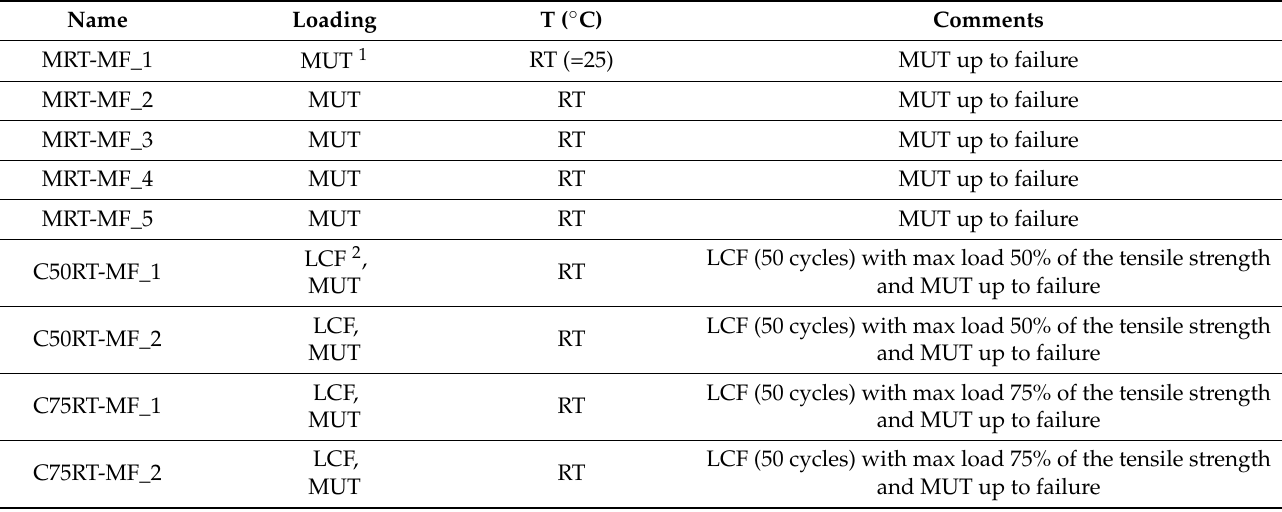
Table 1. Detailed information of experiments under room temperature.